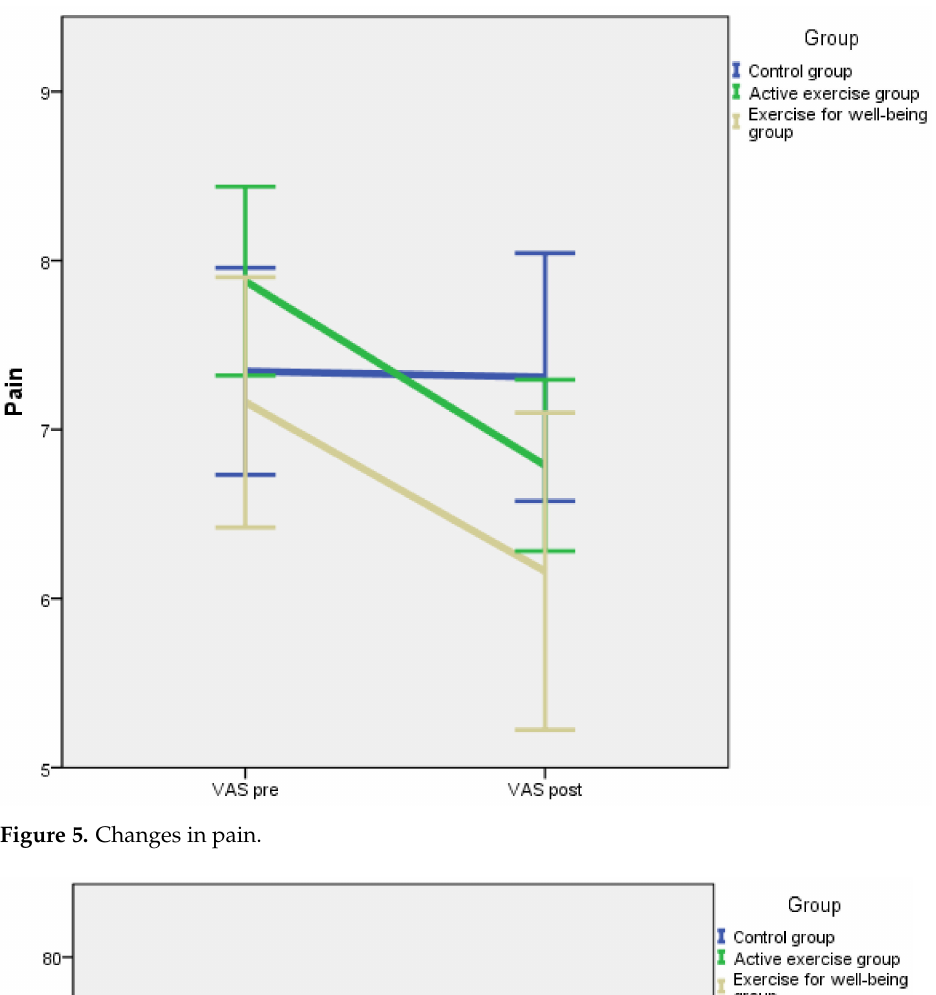
Figure 5. Changes in pain.